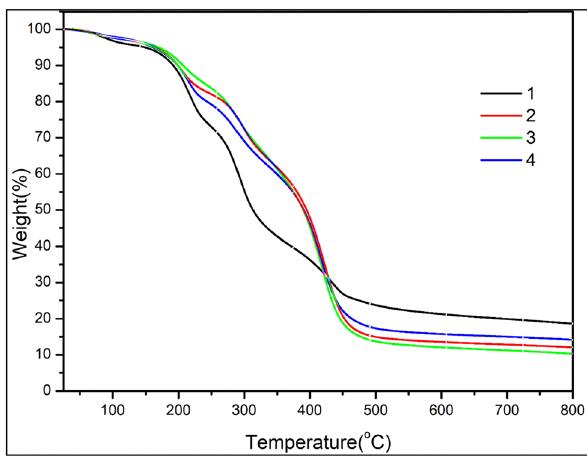
Figure 5: TGA thermograms of fi lms 1, 2, 3, and 4.